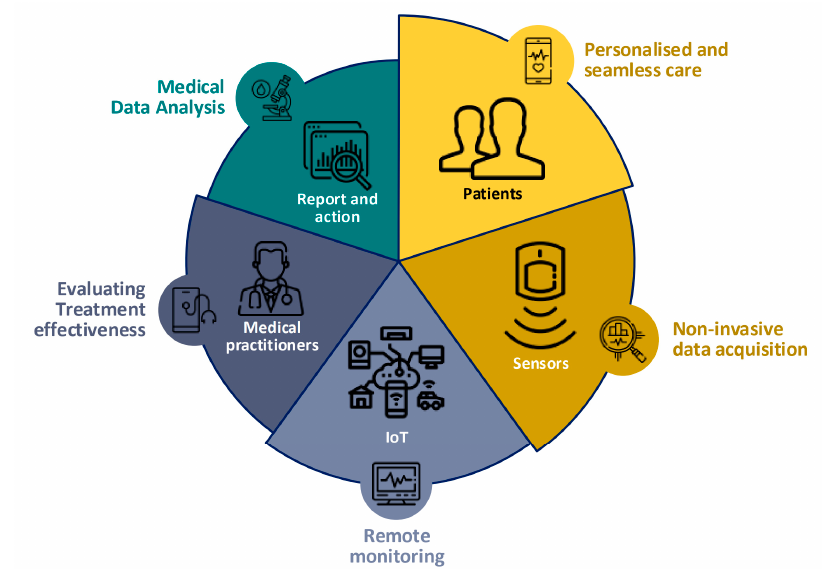
Figure 1. IoT is used in healthcare for varying purposes by different stakeholders (inspired from